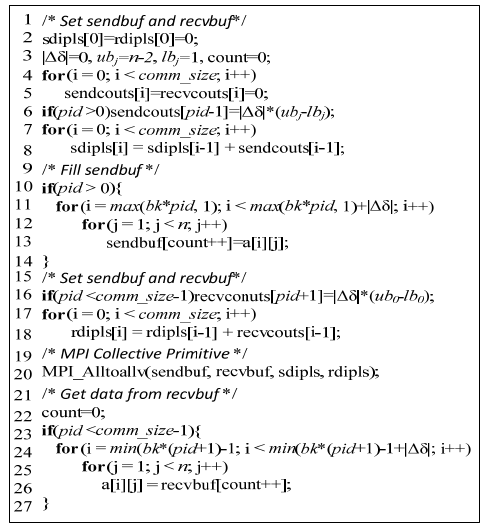
Figure 13. Nearest-neighbor communication code